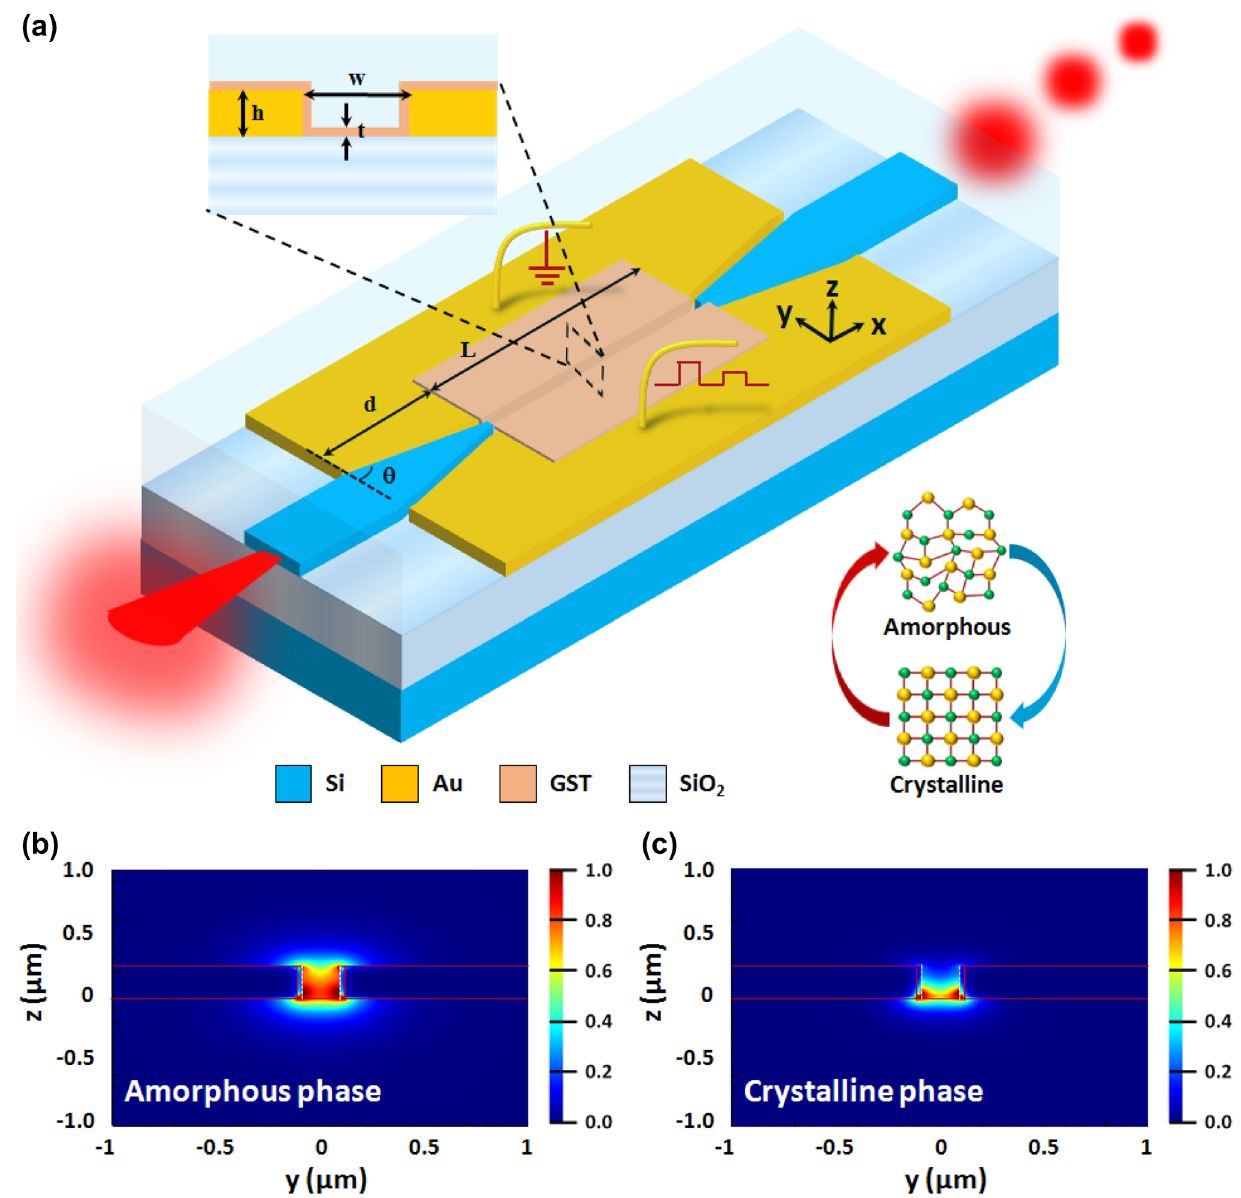
Figure 1. Schematic of the proposed broadband non-volatile hybrid electro-optic plasmonic switch. The inset illustrates the cross-sectional view of the plasmonic slot waveguide with a thin layer of GST. Mode profiles of the PCM (GST) coated plasmonic slot waveguide for the: ( b ) amorphous phase and ( c ) crystalline phase of the PCM at the telecom wavelength of 1550 nm. For both the phases, the mode profiles were calculated for the TE polarization of light. The following optimized geometrical parameters of the PCM coated plasmonic slot waveguide were chosen to calculate the mode profiles—the height of the metal ’h’ was taken to be 220 nm, the width of the slot ’w’ was taken to be 180 nm, and the thickness of the PCM layer ’t’ was taken to be 20 high at 1550 nm. Figure 2a shows the overall extinction ratio spectrum. The extinction ratio is defined as the dif- ference in insertion loss between the ON and the OFF states. The ER spectrum shows the broadband nature of the plasmonic switch with a bandwidth of over 400 nm by considering the operating extinction ratio of > 20 dB. The ER is 29 dB at 1550 nm wavelength. The optimization of the GST thickness of the plasmonic switch is discussed in supplementary Sect. 2 (see Figs. S1(a)–(d)). The Figure-of-Merit (FoM) for a switch to determine its performance is defined as FoM = ER/IL ON . The FoM for the electro-optic plasmonic switch being proposed in this paper was calculated to be 21 (at a wavelength of 1550 nm), which is higher than that reported in previous works 27,42–45 . A comparison of our proposed plasmonic switch with other PCM based integrated optical switches—in terms of different switching parameters—is shown in Table S1 (in the supplementary Sect. 4). The effect of the length of the plasmonic slot waveguide on the Insertion loss and Extinction ratio has been shown in supplementary Sect. 2. We have calculated the IL and ER for the waveguide lengths of 250 nm, 375 nm and 500 nm (see Fig. S2 in the